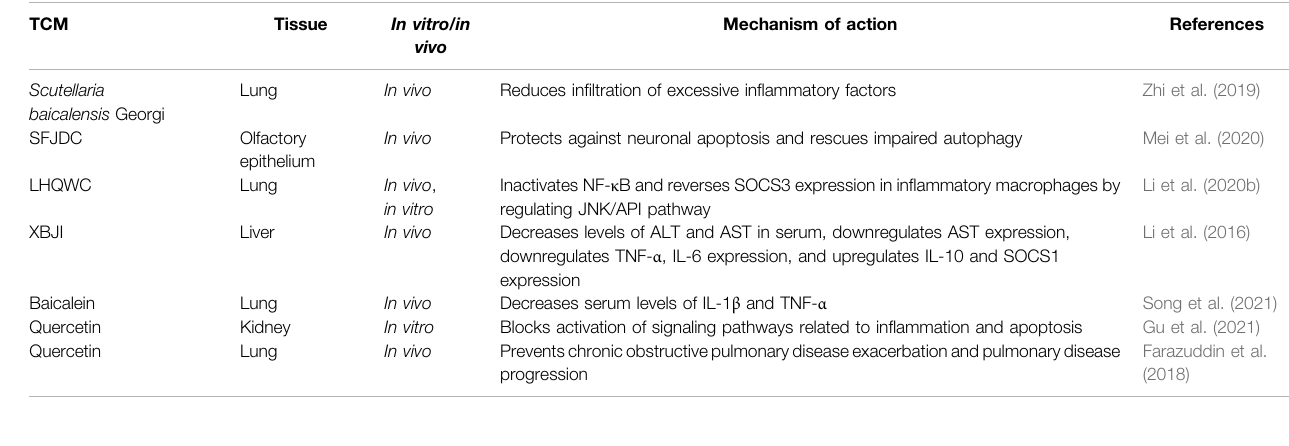
TABLE 5 | Tissue-protecting TCMs.